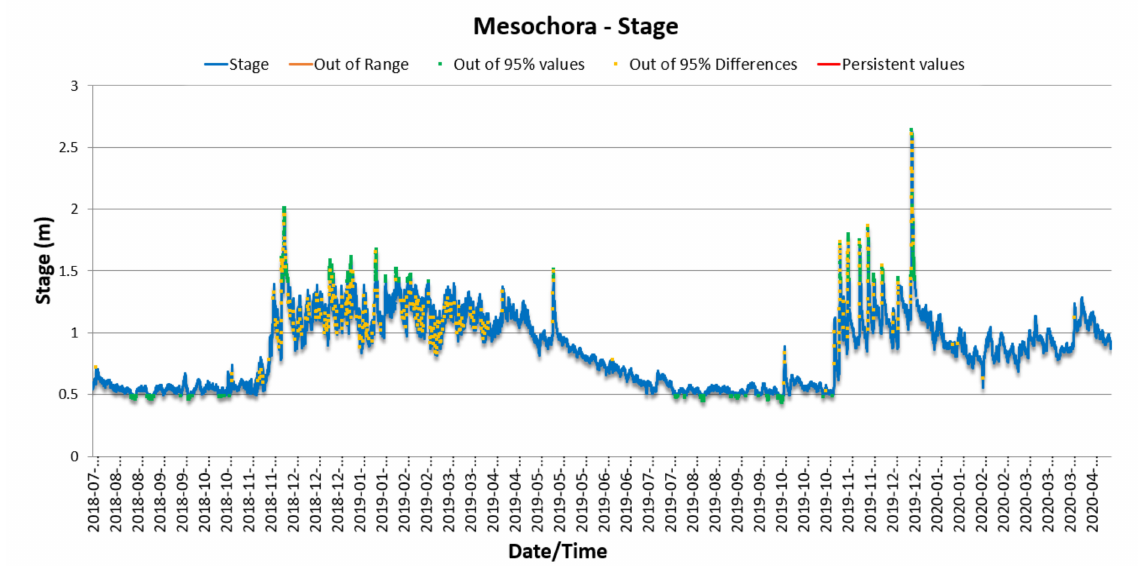
Figure 7. Change of water level with time (hourly values) at Mesochora station and flagging of the 5% greatest/lowest hourly observations and differences of successive ones. No erroneous values are suspected in this typical graph of the water level